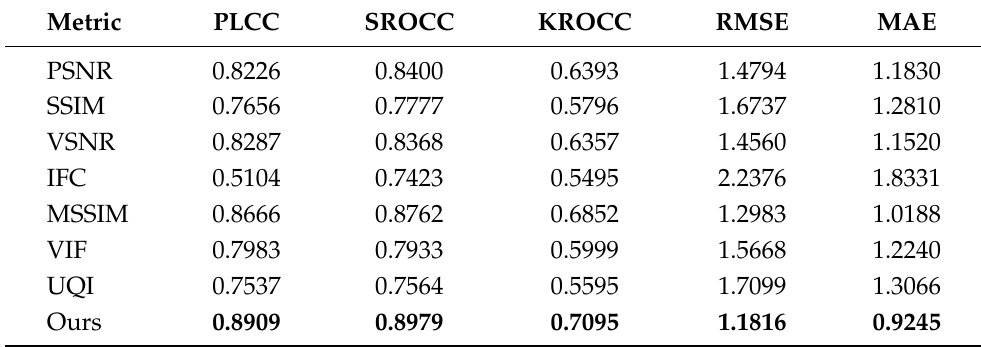
Table 1. Overall performance comparison of the proposed and the compared 2D image quality assessment metrics on MCL-3D dataset. The best results are highlighted in bold.